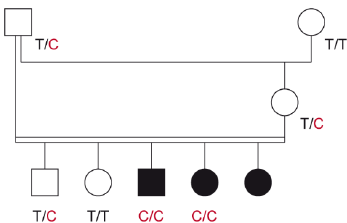
Figure 1. Pedigree of the investigated Australian Shepherd family. Squares represent males and circles represent females. The three affected puppies are indicated by the filled symbols. Note that the father of the litter was simultaneously the maternal grandfather. A close inbreeding loop greatly increases the risk for recessive hereditary defects. Genotypes at the LAMB3 :c.1174T > C variant are indicated for all animals, from which a DNA sample is available (see Section